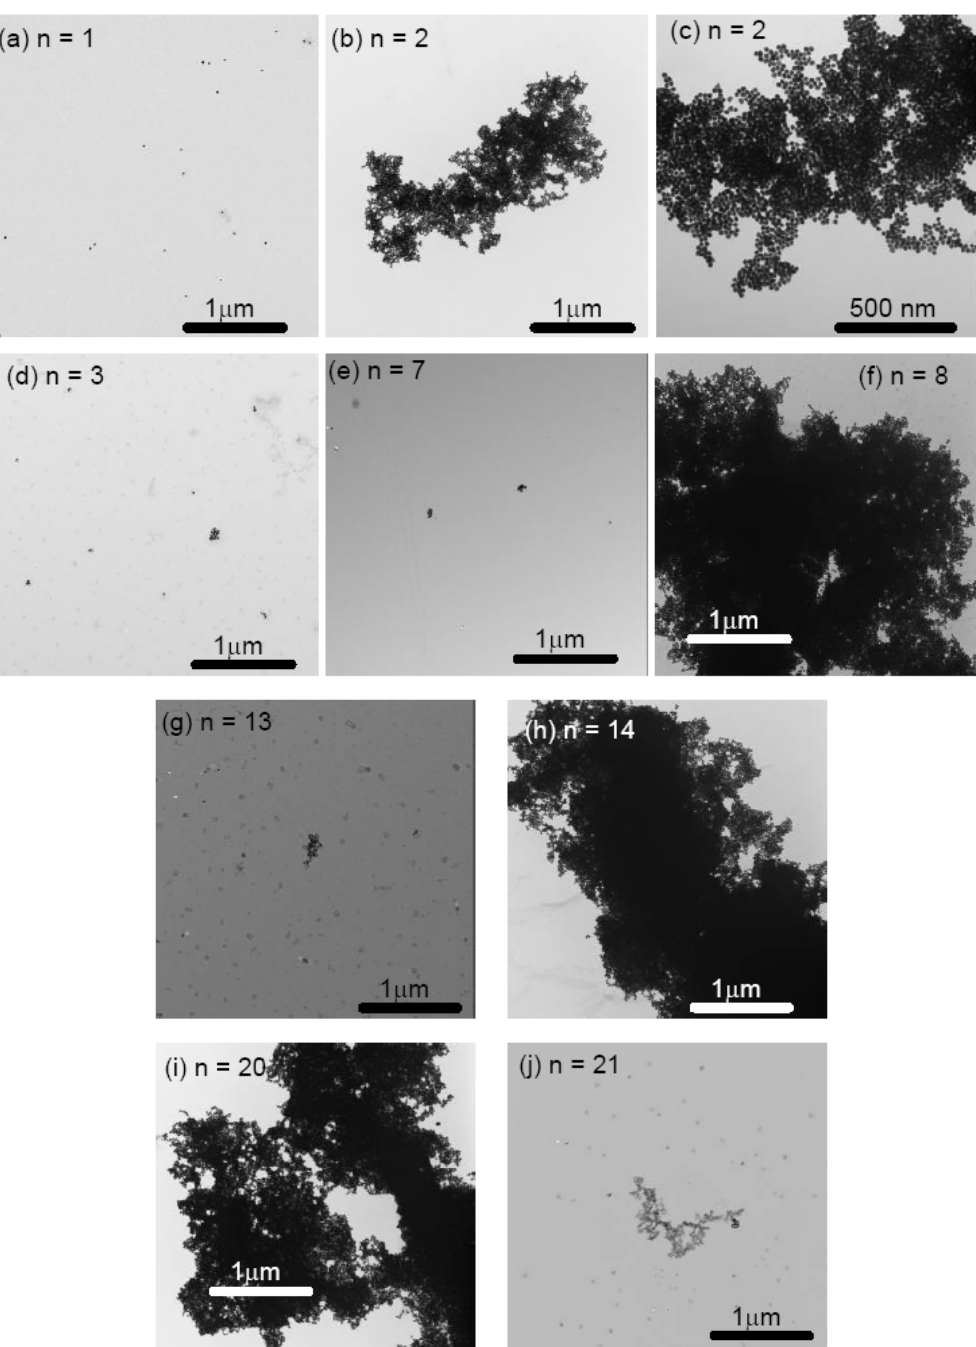
Figure 10. The TEM images of ovalbumin coated 20 nm gold colloids (a) n = 1 (pH 7), (b) n = 2 (pH 4), (c) n = 2 (pH 4), (d) n = 3 (pH 10), (e) n = 7 (pH 10), (f) n = 8 (pH 4), (g) n = 13 (pH 10), (h) n = 14 (pH 4), (i) n = 20 (pH 4), and (j) n = 21 (pH